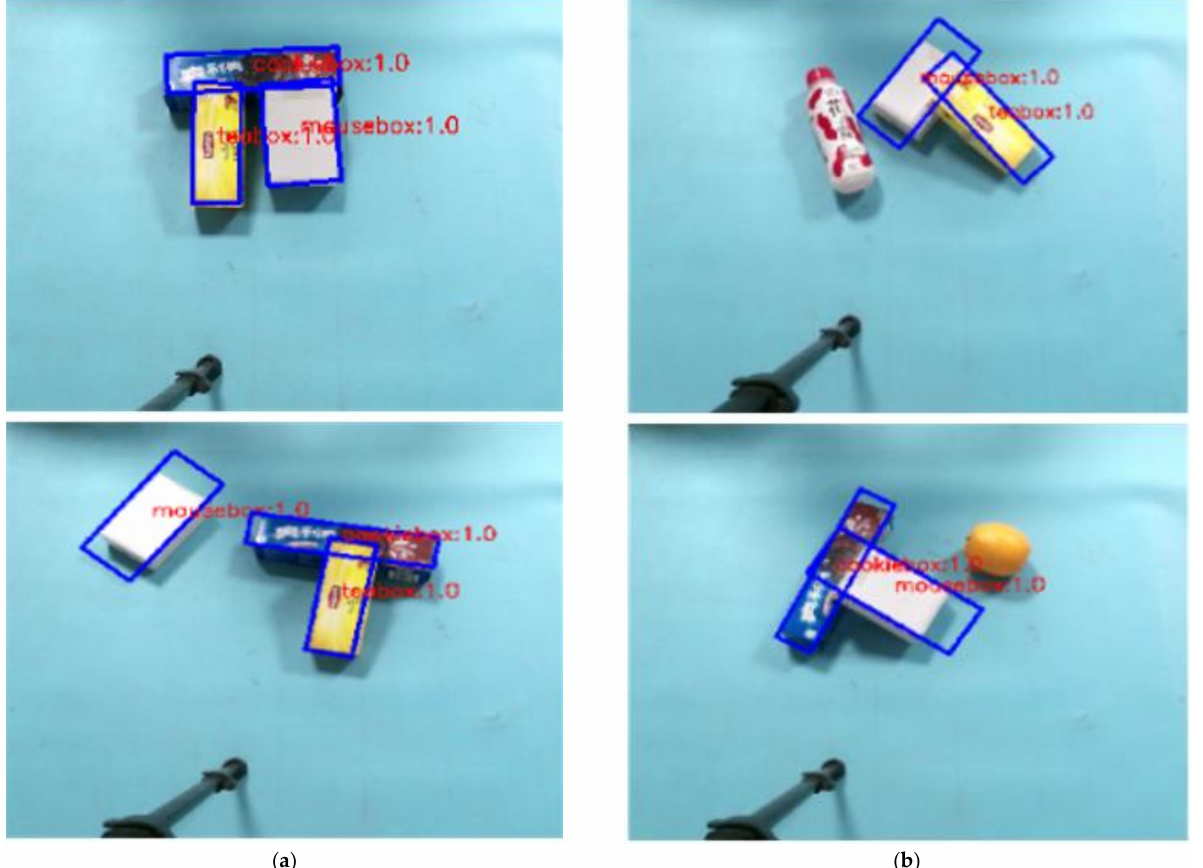
Figure 17. Prediction effect of rotating target detection network in actual scene. ( a ) The training set object in the scene; ( b ) the scene containing untrained